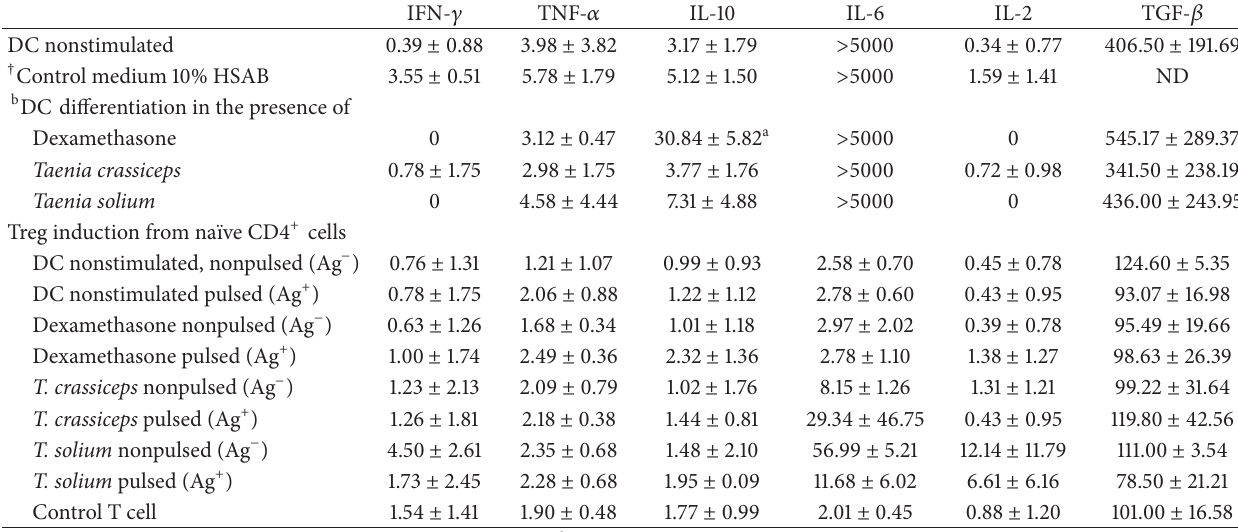
Table 1: Levels of cytokines in supernatants from in vitro DC differentiation and in vitro regulatory T cell induction.